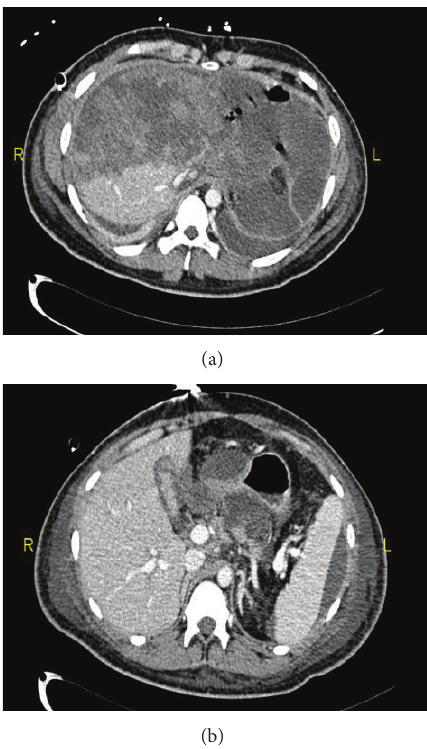
Figure 1: (a) Admission IV contrasts abdomen CT scan showing extensive liver injury with active blush; (b) fluid around spleen and liver.